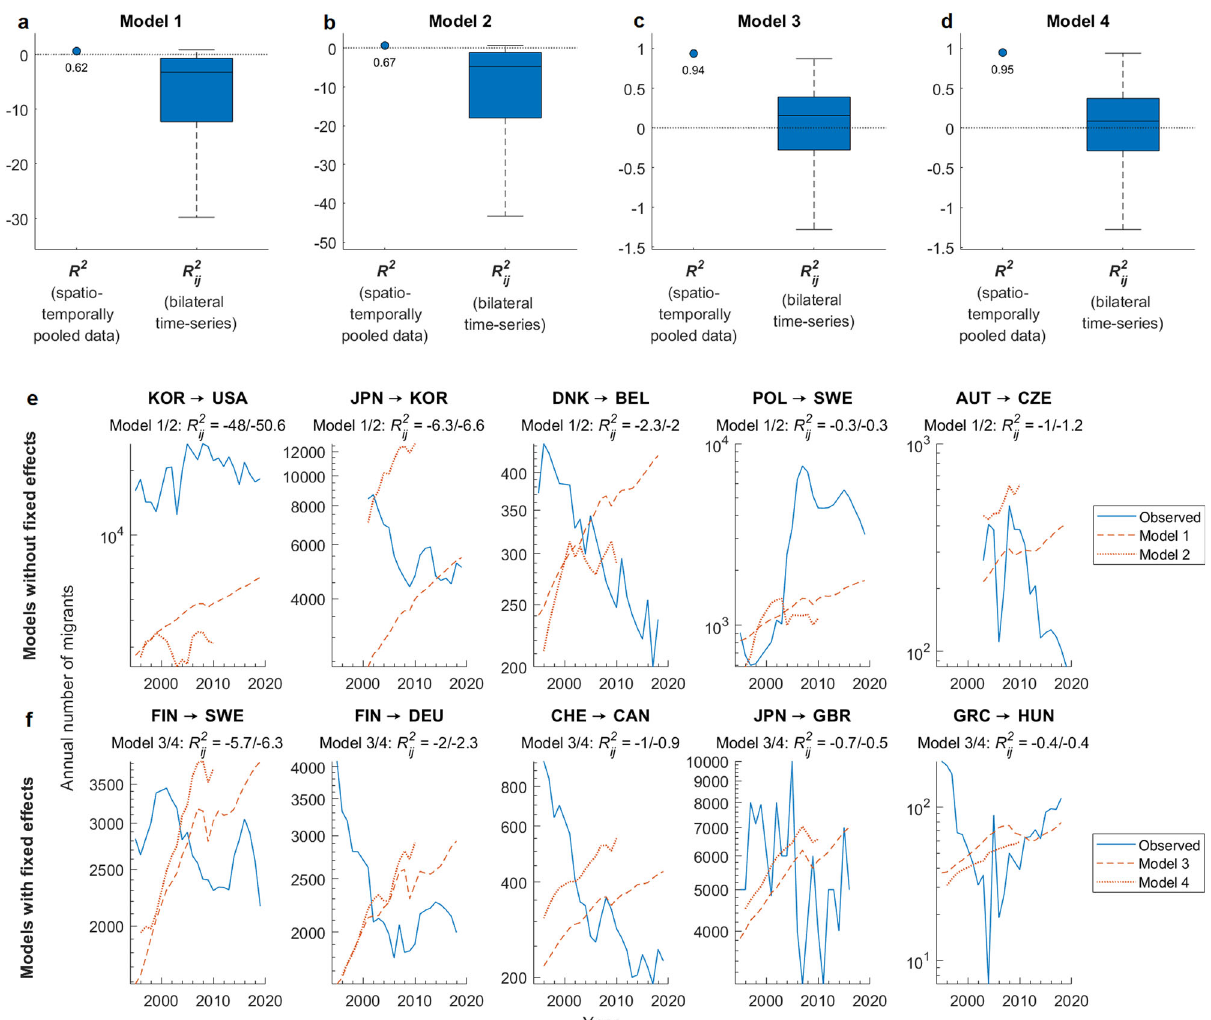
Fig. 3 Modelled and observed migration fl ows at the bilateral level. In panels a – d , the R 2 values represented by markers correspond to the comparisons shown in Fig. 1a – d, respectively. Boxplots (not showing outliers, which are as small as − 663, − 1.2 × 10 6 , − 7.7, and − 89 for Models 1 – 4, respectively) represent the set of R 2 ij values obtained from the comparison of modelled and observed annual data over time for each speci fi c country of origin i and destination j (Eq. (8)). Five examples of these scenarios are shown for the models e without and f with fi xed effects. Blue lines represent observed migration fl ows, orange lines represent modelled data. By design of the fi xed-effects models, fl ows simulated by the Models 3 and 4 intersect the observed time-series at least once.